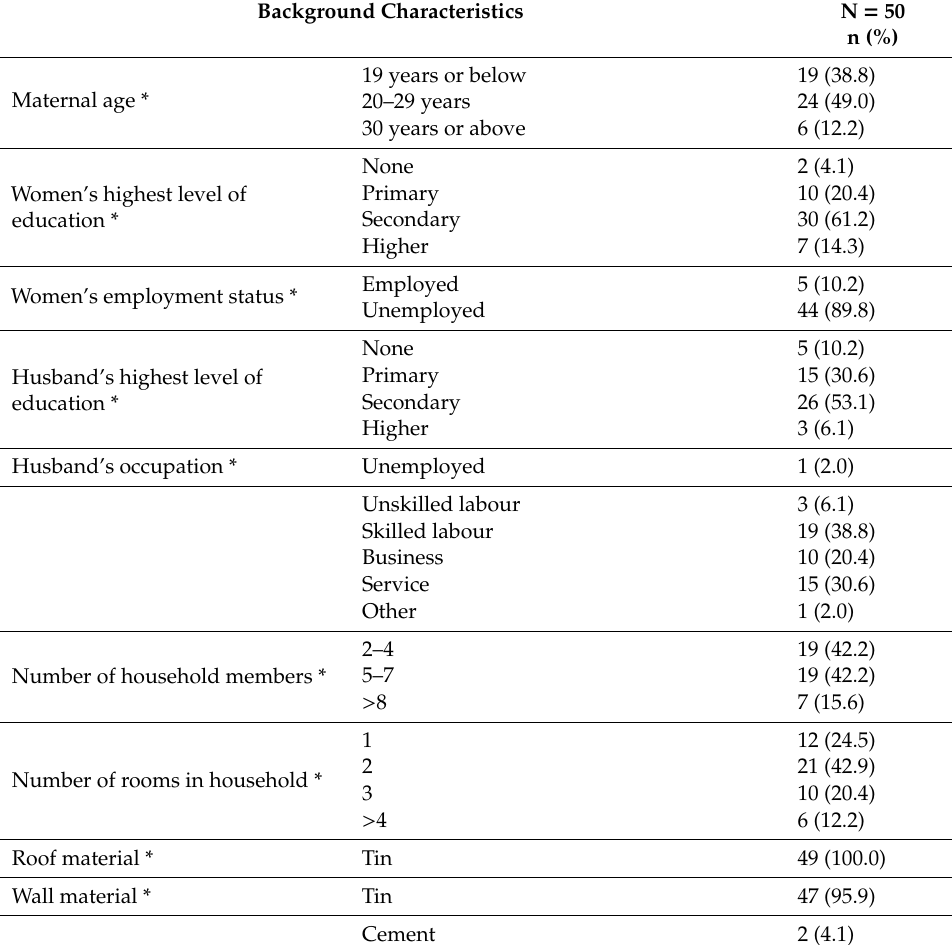
Table 1. Background characteristics of the study